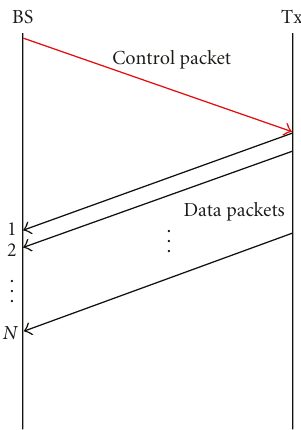
Figure 3: Packet transmission